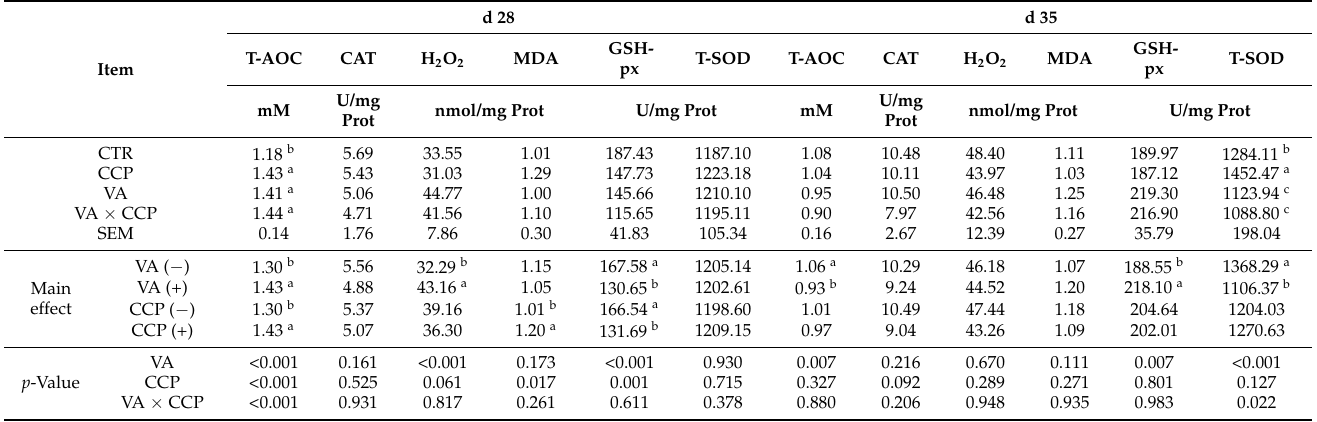
Table 5. Effect of vitamin A on the levels of antioxidant enzymes and peroxidation products in the liver of CCP-challenged